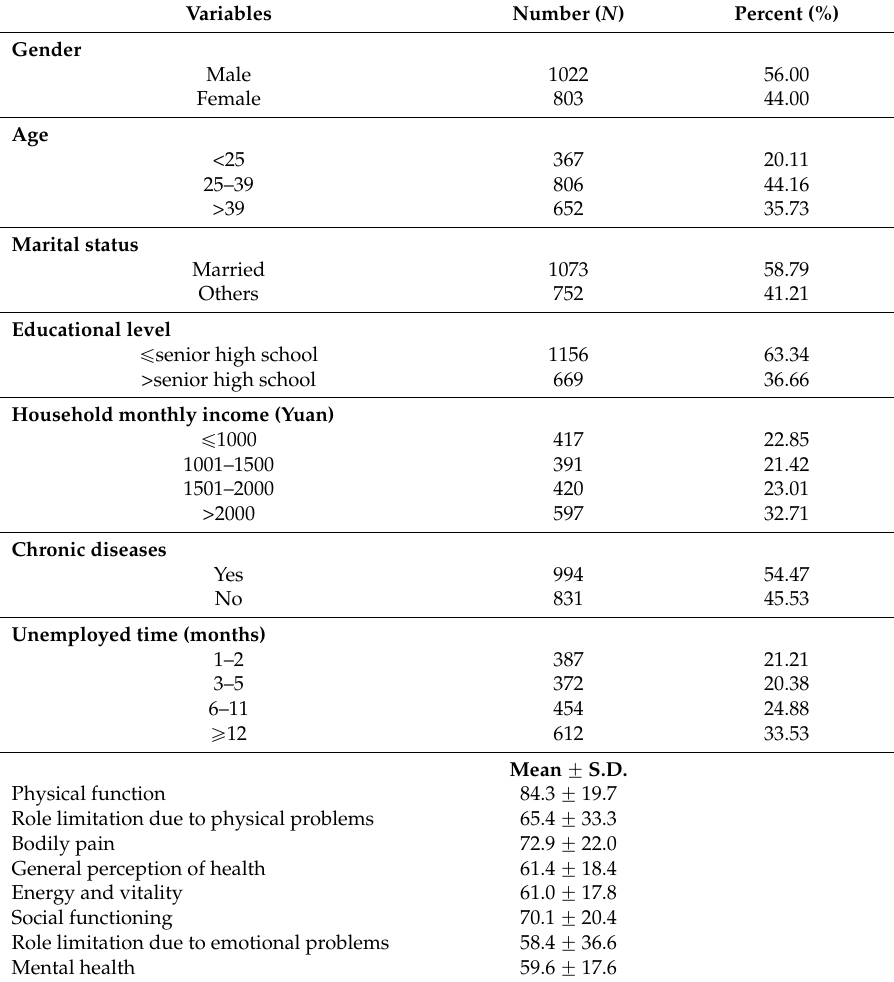
Table 1. Demographic characteristics of unemployed people ( N =